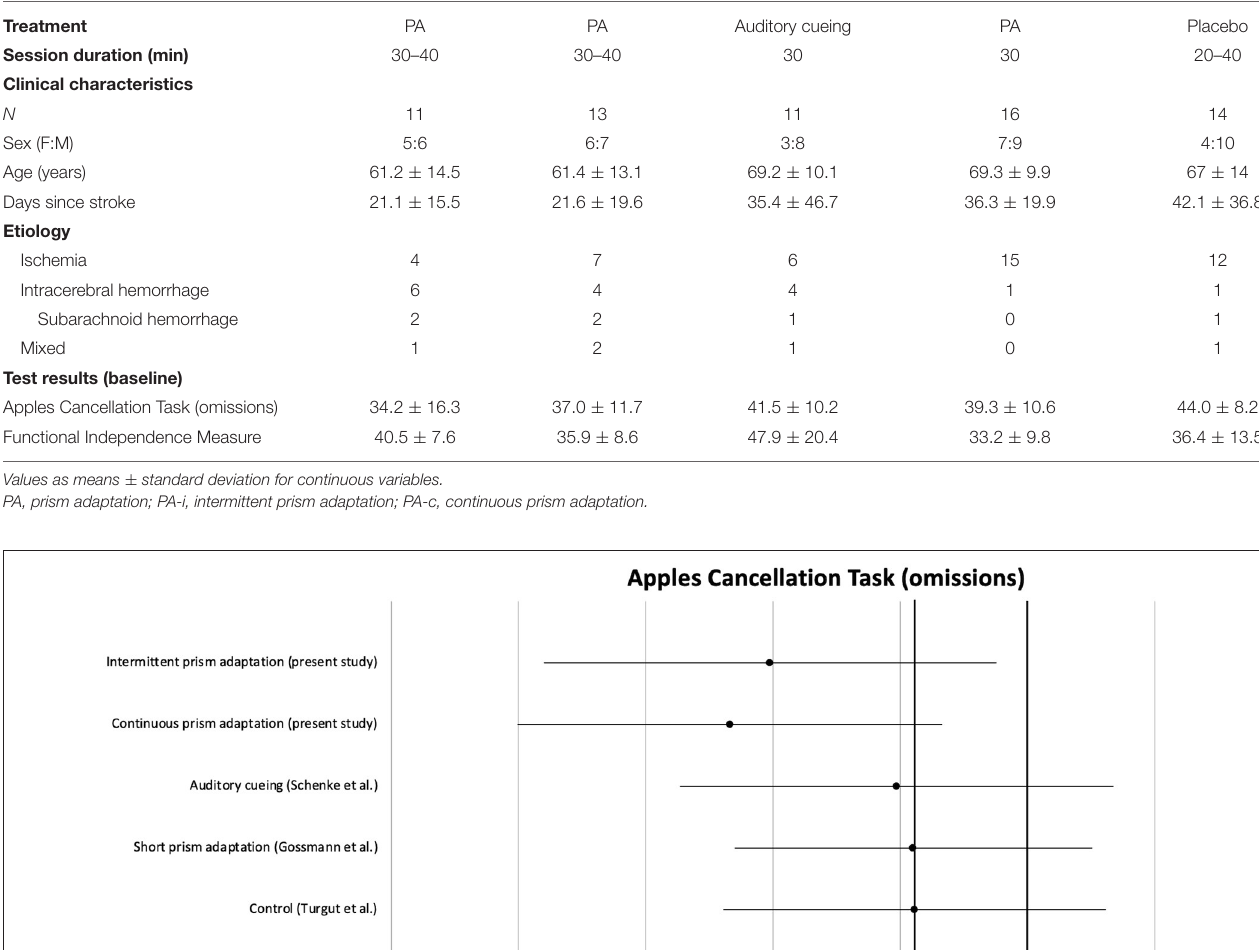
TABLE 5 | Clinical characteristics of the present prism adaptation treatment protocols (first condition only) and previous studies on neglect interventions. PA-i PA-c Schenke et al.